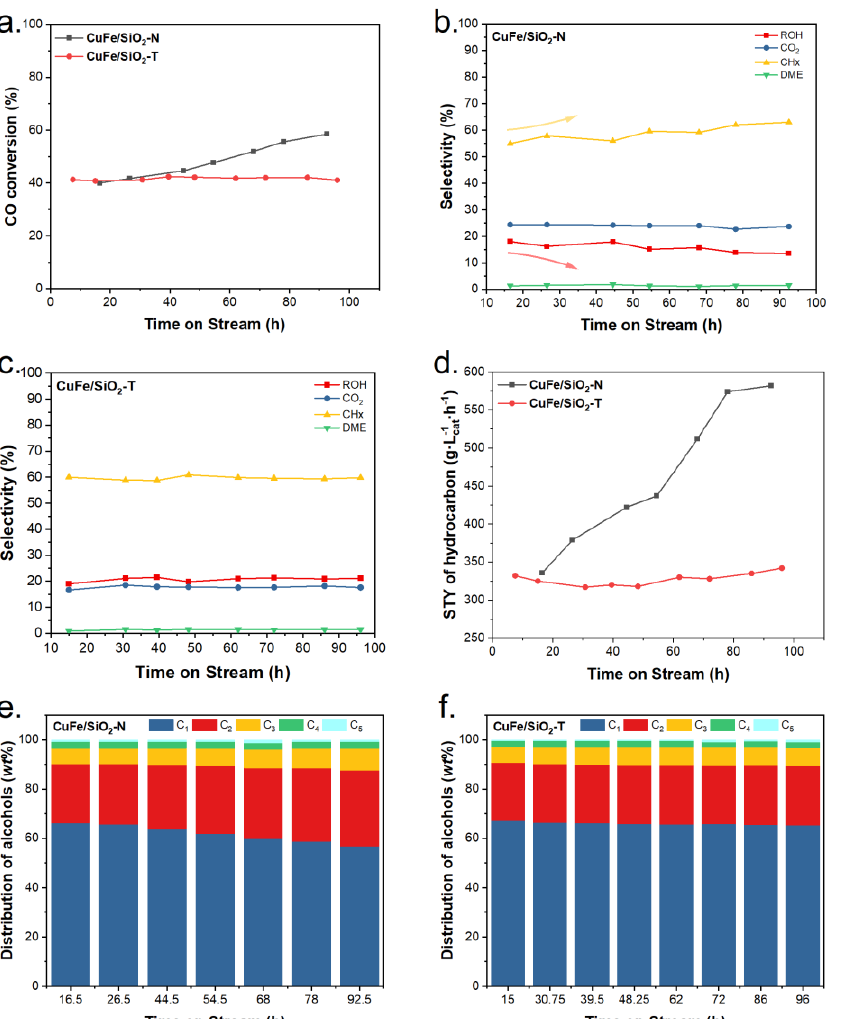
Figure 7. Catalytic performance of CuFe/SiO 2 -N and CuFe/SiO 2 -T catalysts: ( a ) CO conversion; ( b , c ) selectivity (C mol %) of different products; ( d ) STY of hydrocarbons; ( e , f ) and distribution of alcohols (250 ◦ C, 5 MPa, 3000 h − 1 ).